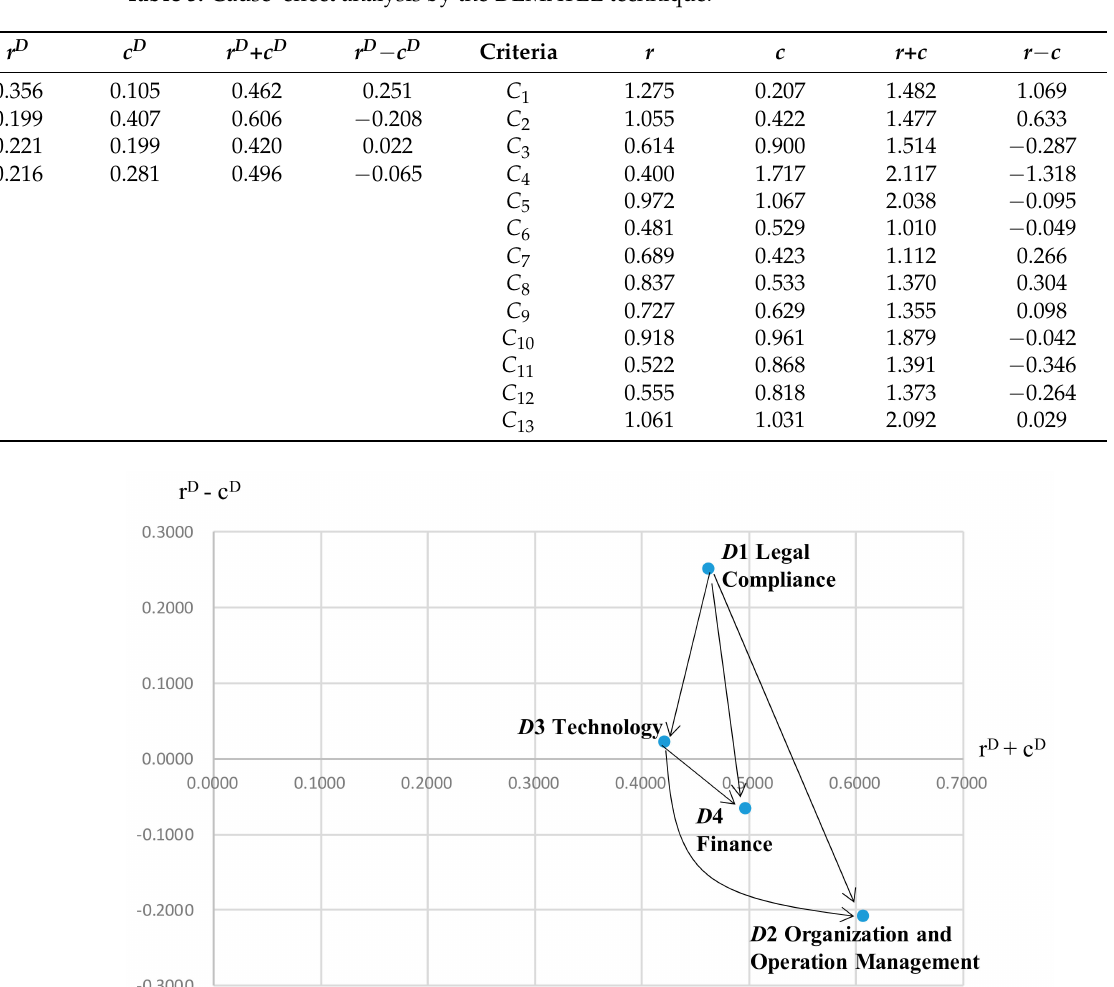
Table 5. Cause–effect analysis by the DEMATEL technique.